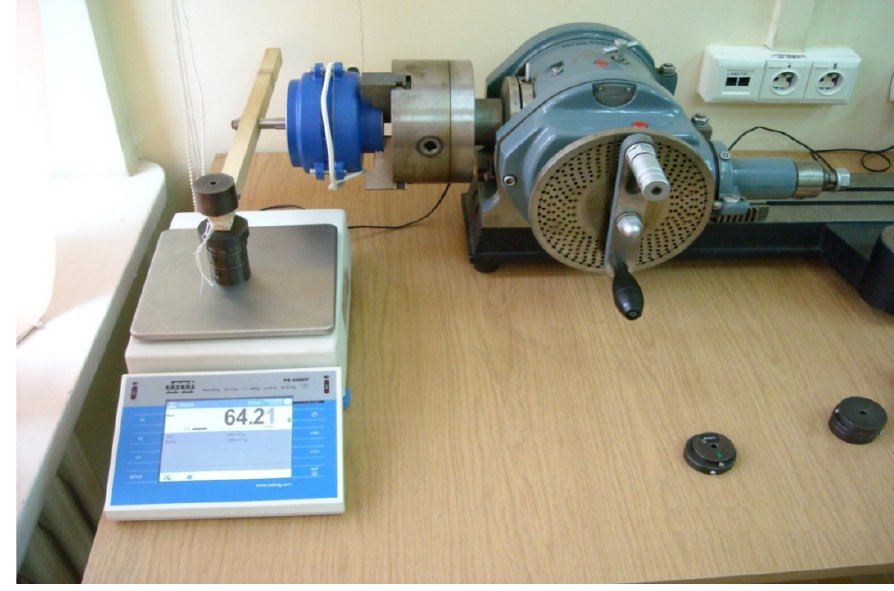
Figure 11. Cogging torque measurement stand.